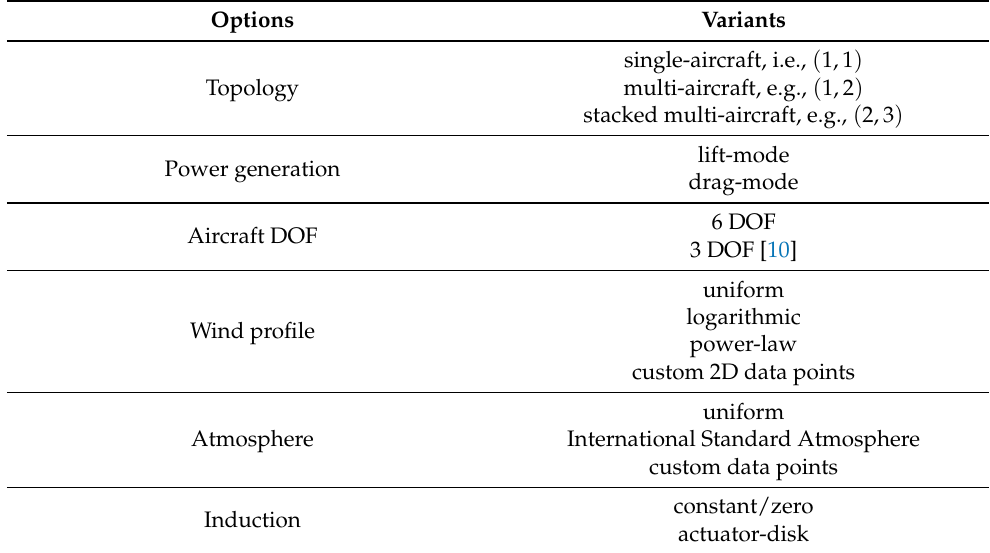
Table 1. Main AWE system modeling options and possible variants implemented in awebox